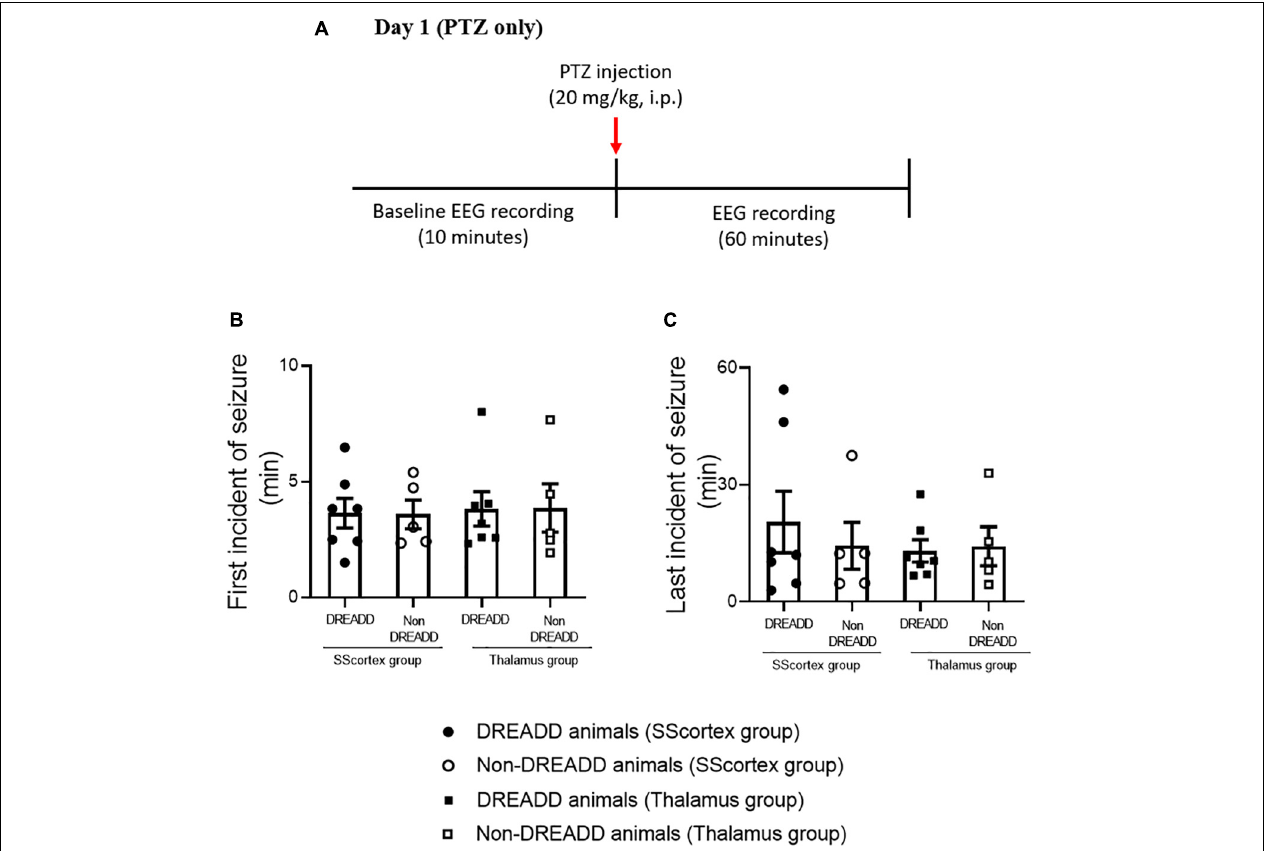
FIGURE 3 | (A) Schematic of protocol for EEG recordings before and after PTZ injection on day 1 in experimental animals. Comparison of (B) onset of seizure and (C) last incident of seizure during 1 h of EEG recording in PV Cre /Gq-DREADD (DREADD) ( n = 7) and non-DREADD ( n = 5) WT control animals of the SScortex group and the RTN thalamus group after PTZ treatment on day 1. All values in graphs represent mean ± SEM. Comparison between treatment groups was performed using Mann Whitney unpaired rank